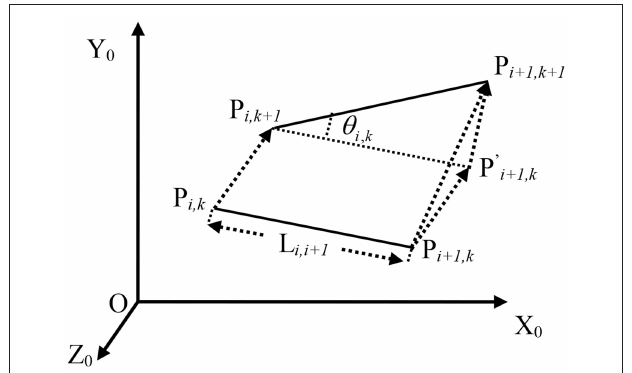
FIGURE 3 | The status of points from i to i